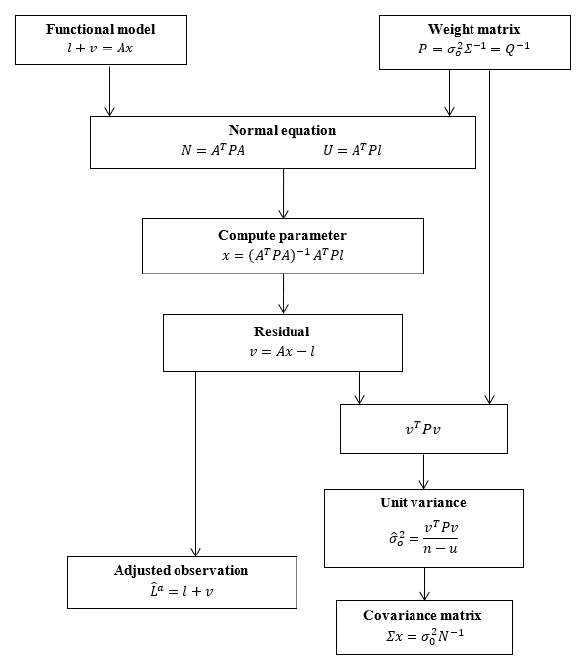
Figure 4. The procedure of least squares adjustment